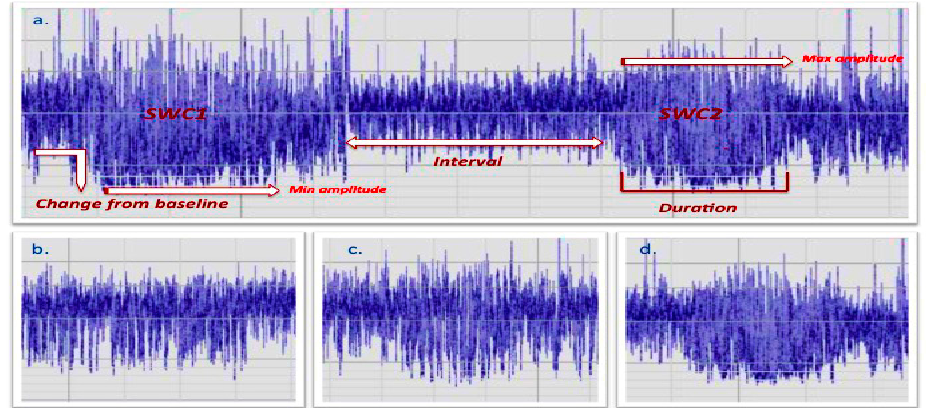
Figure 1. Representation of the aEEG sleep–wake cycling. ( a ) Representation of the aEEG epoch. Quite sleep epochs were defined as: (1) not well defined/fragmented ( b ); (2) defined but fragmented ( c ); or (3) defined and not fragmented ( d ). All aEEG characteristics were scored for the first and the second QS phase and the transition from one QS phase to the other in order to allow comparison before and after music exposure.